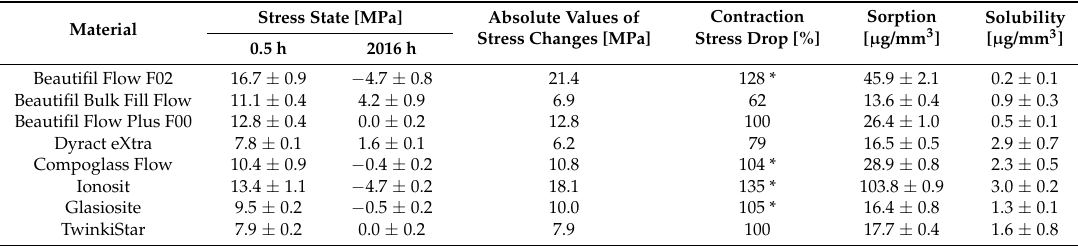
Table 3. Stress state before (0.5 h) and after 2016 h (84 days) of water immersion, contraction stress drop, absorbency and solubility of tested materials.